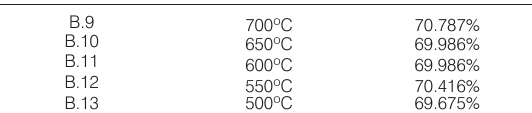
Table 3. TMC of samples by